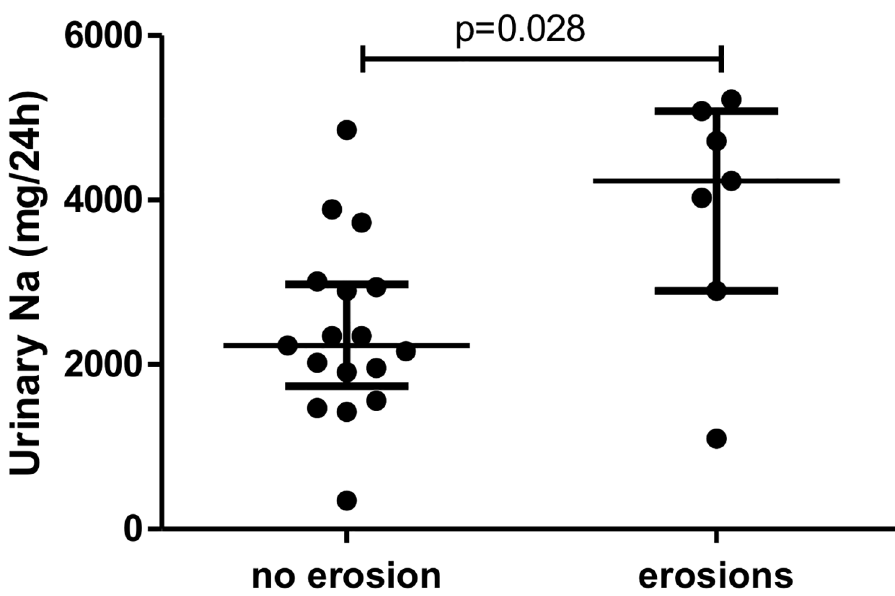
Fig 2. Sodium excretion was higher in early RA patients with erosions than in those without. Horizontalbars are medianand whiskers are IQR comparedby Mann-Whitney test.